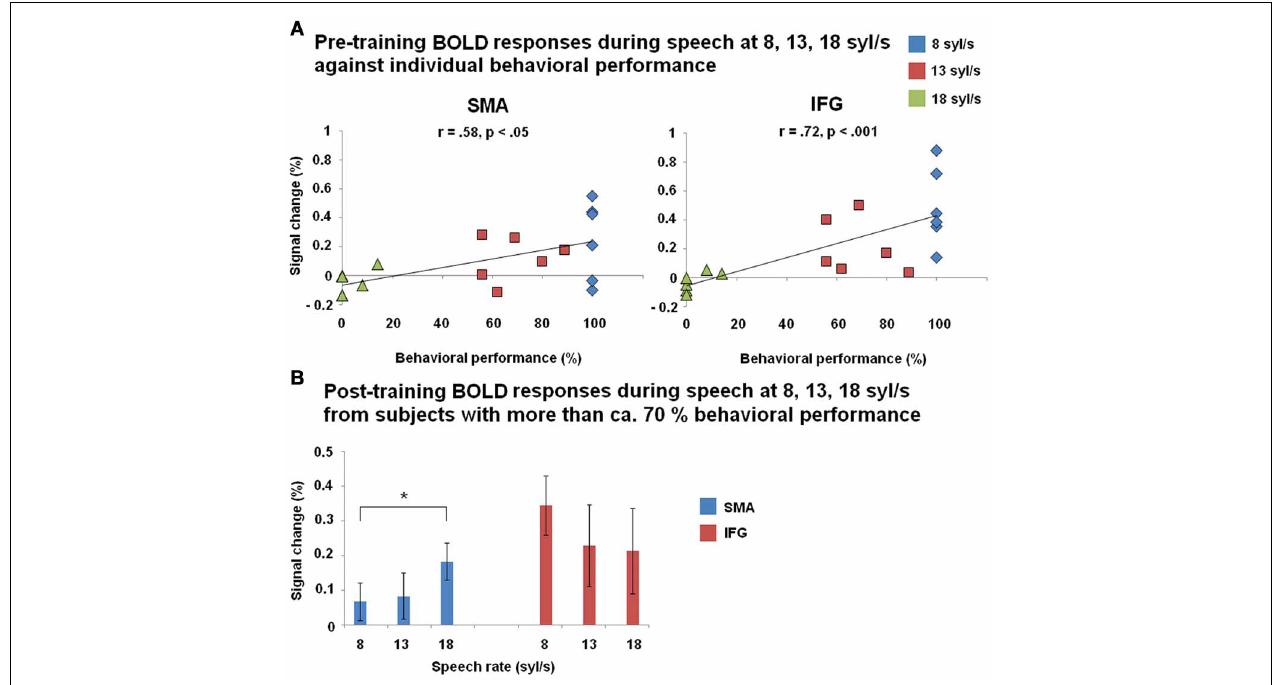
FIGURE 6 | (A) Correlation between BOLD responses during forward speech pre-training and individual behavioral performance within left SMA and inferior frontal gyrus (IFG) across all three speech rates (8, 13, 18syl/s) and across all subjects. (B) BOLD responses during forward speech post-training for each